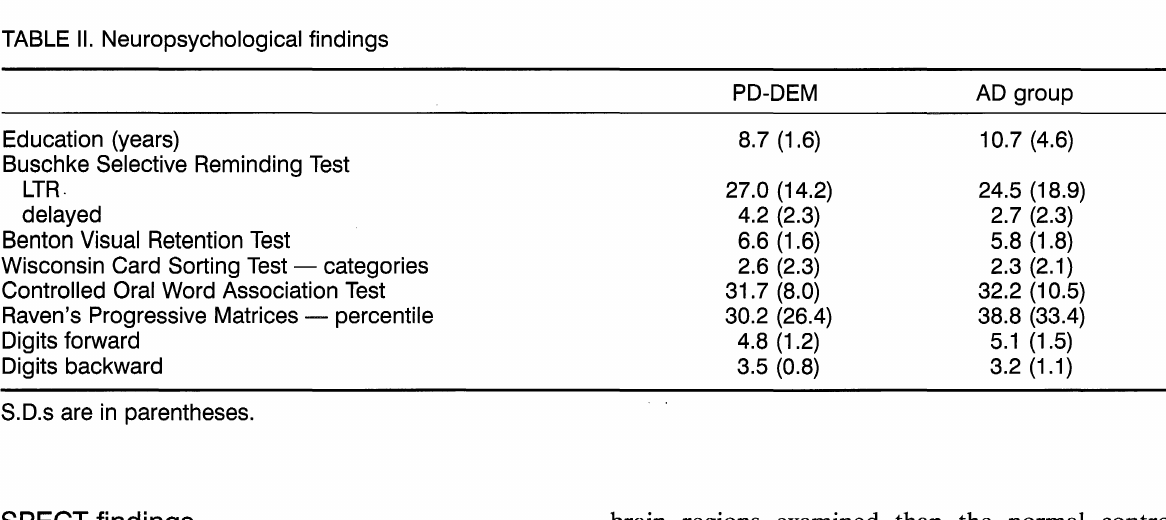
TABLE II. Neuropsychological findings